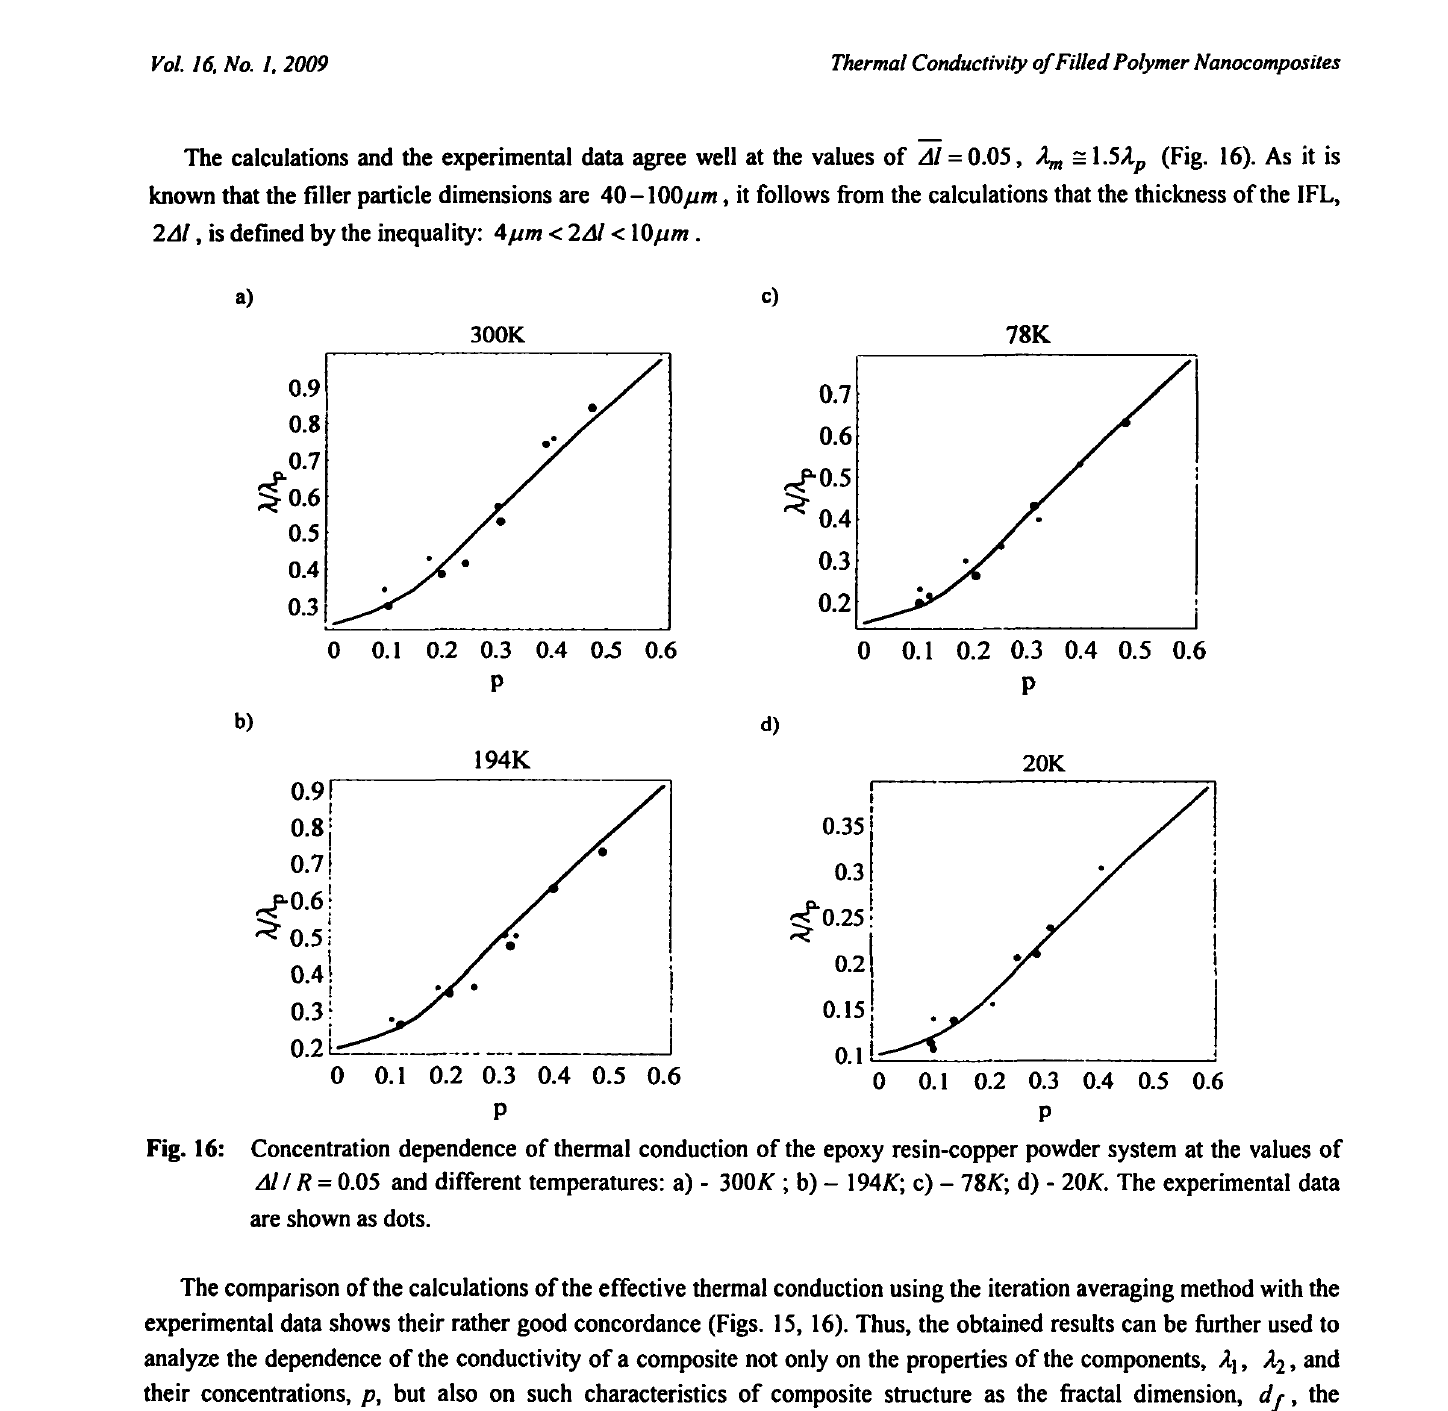
Fig. 16: Concentration dependence of thermal conduction of the epoxy resin-copper powder system at the values of AIIR = 0.05 and different temperatures: a) - 300A"; b) - \94K; c) - 78ΛΓ; d) - 2QK. The experimental data are shown as